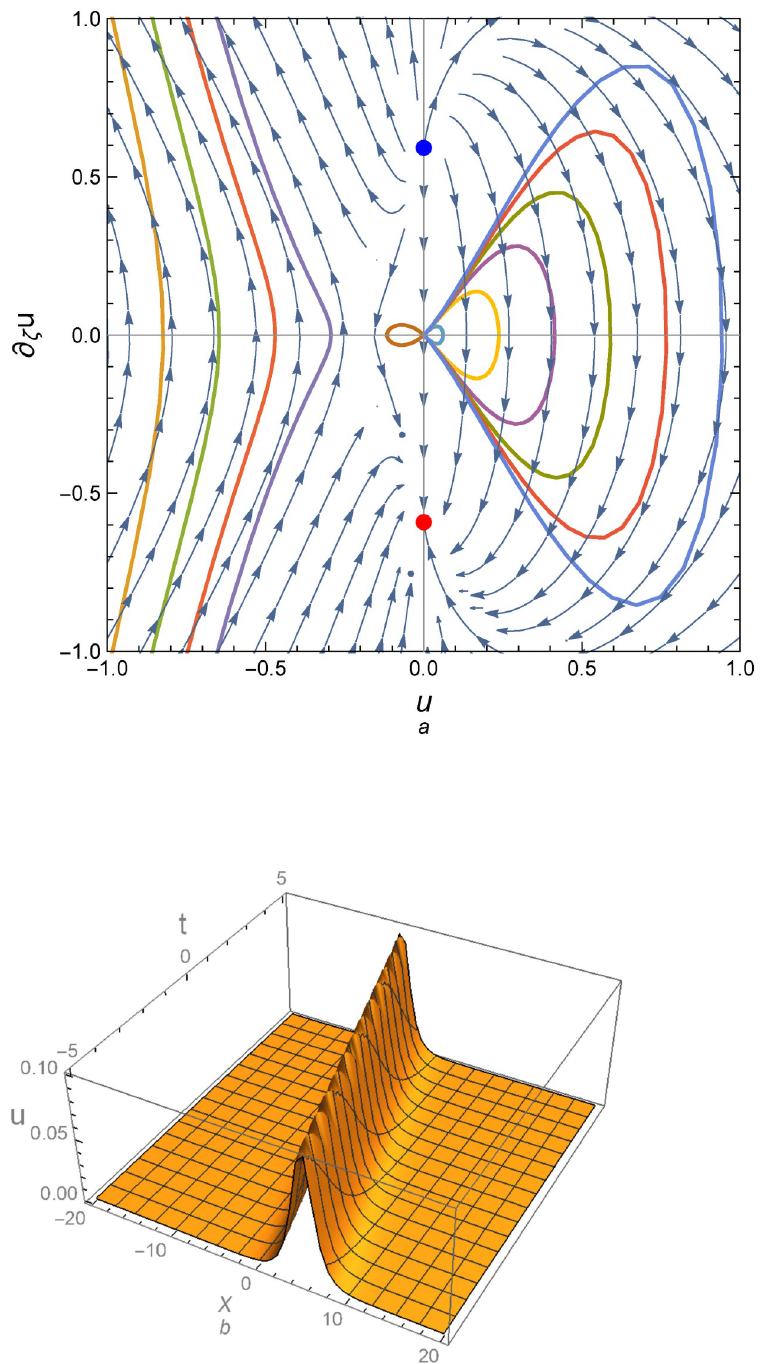
Fig 4. Phase portrait for system (17) for the parametric values c 0 = 1, c 1 = − 0.2, c 2 = 1, c 3 = − 1.61, α = 1, γ = 1, ε = 1, λ = 1, k = 1, D = 0.35 and (b) Profile of peakon solution for the same parametric values.